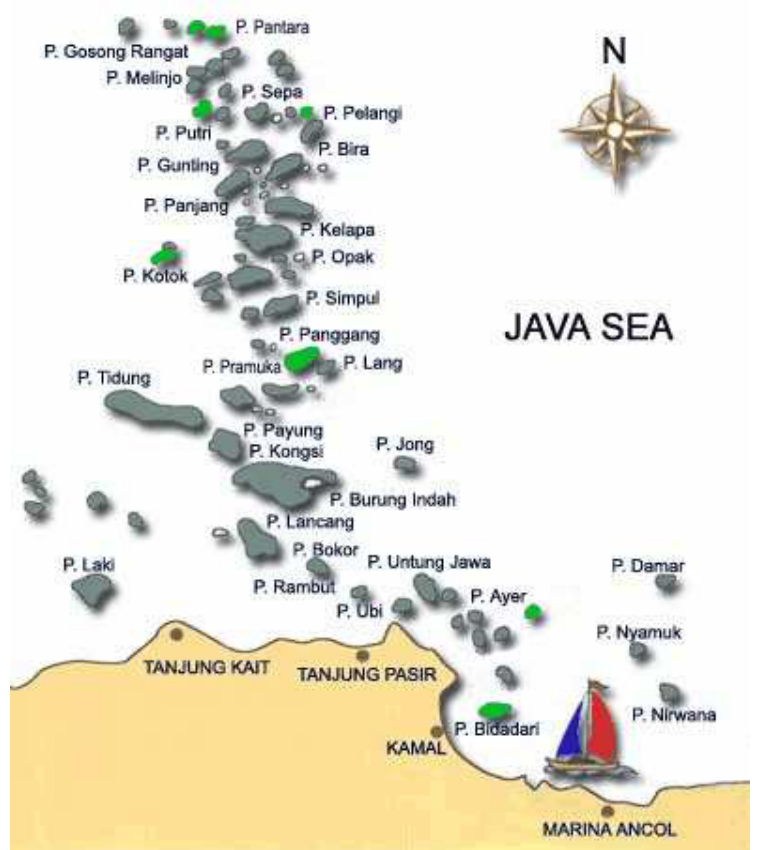
Figure 1. The Map of Kepulauan